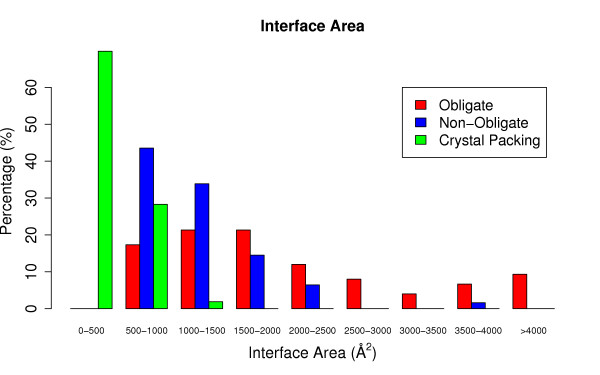
Distribution of interface area for three types of interactions in the BNCP-CS dataset.